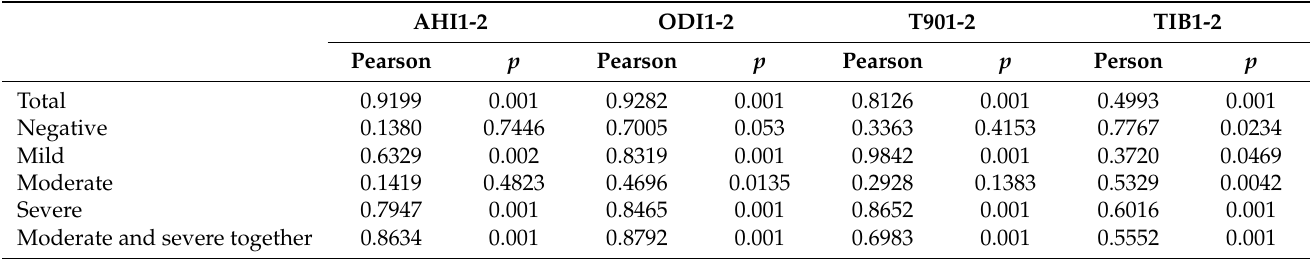
Table 2. Pearson’s correlation of the AHI, ODI, T90, and TIB of the two consecutive polygraphic examinations (see text).